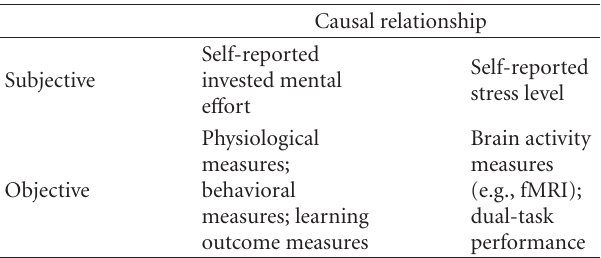
Table 1: Classification of methods for measuring cognitive load based on objectivity and causal relationship (adapted from